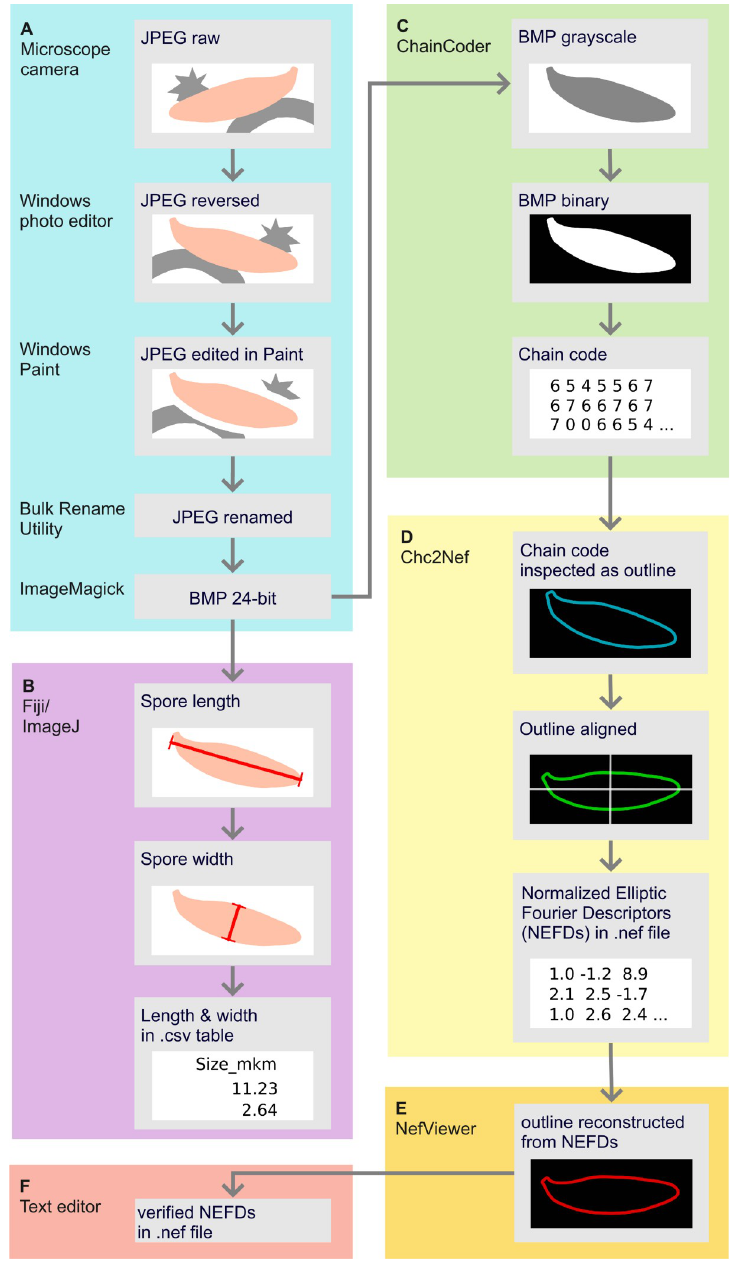
Fig 2. Workflow showing the extraction of the shape and size information from a fungal spore. (A) Image capture and pre-processing, (B) Acquiring linear measurements (C) Acquiring chain codes (D) Transforming chain codes to normalized elliptic Fourier descriptors (E) Checking quality and orientation of the outlines (F) Option to open and manage outline descriptors in a text editor. The names of tools and programs used at each step are on the left side of each colored panel. Republished from [30] under a CC BY license, with permission from protocols.io, original copyright